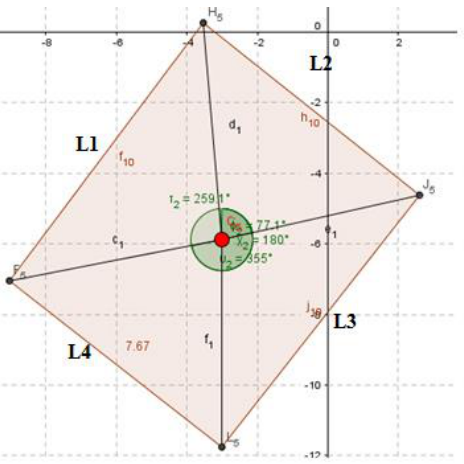
Figure 5: Room 10 as a normal case where the red point represents the position of the rangefinder and black points represent measured